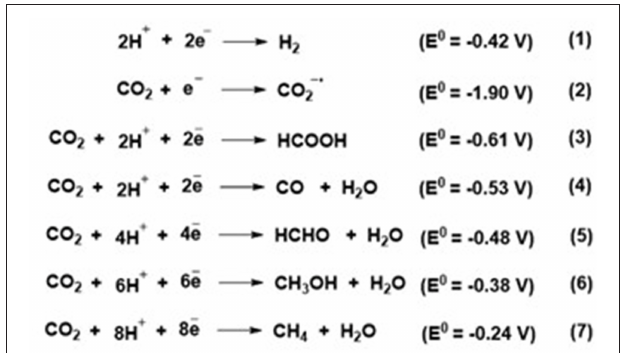
FIGURE 1 | Schematic representation for free energy change for electrochemical conversion of CO 2 to CO in water (solid line) or ionic liquid (dotted line). Adopted from Li et al.